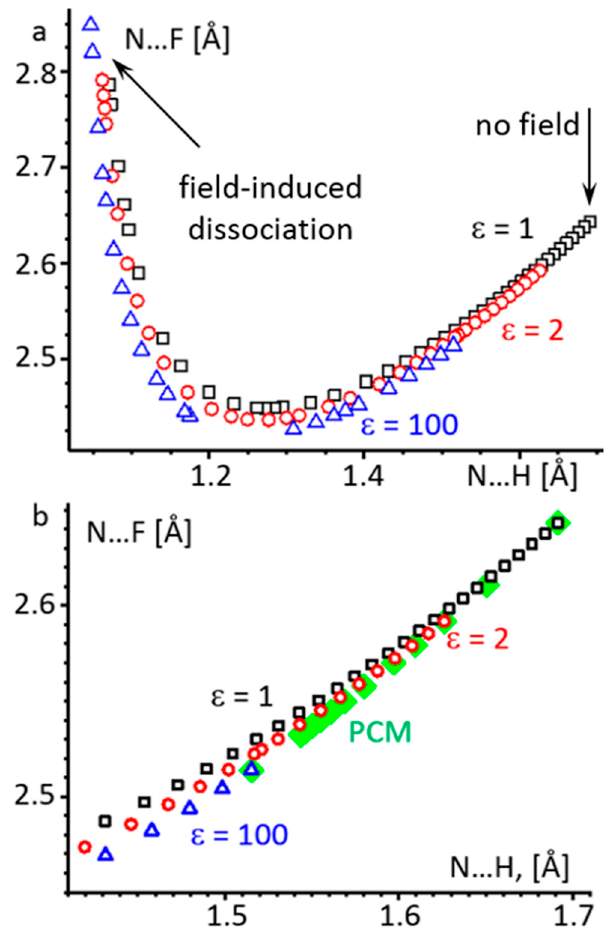
Figure 6. ( a ) A correlation between the H 3 N ··· H and N ··· F distances of H 3 N ··· HF under the effect of an external electric field at the gas-phase ( ε = 1, black squares) and PCM ( ε = 2, red circles and ε = 100, blue triangles) approximations. ( b ) This correlation for the region of small hydrogen bond perturbation, including the PCM approximation region (green squares).